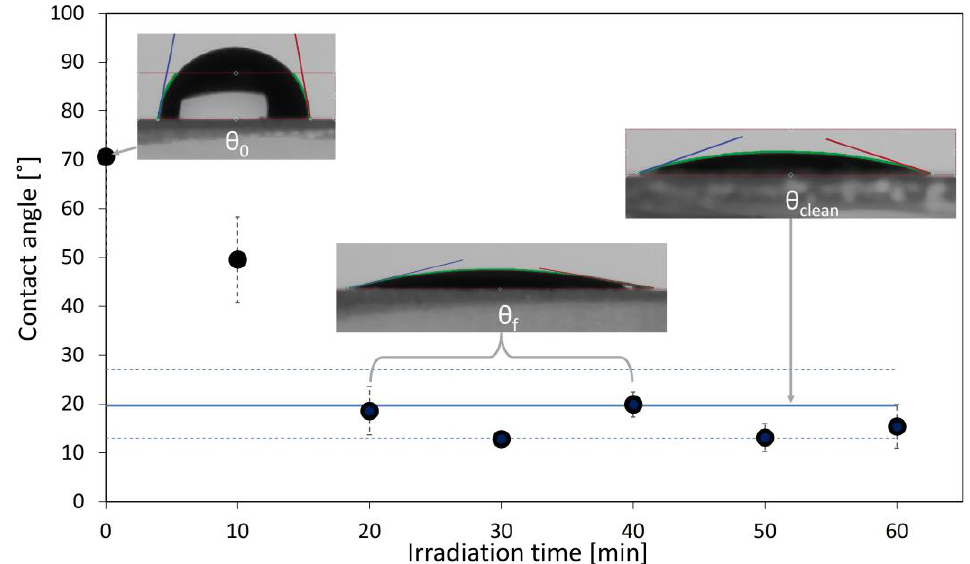
Figure 3. Example of the typical evolution of the water contact angle for a smooth, hydrophilic, photocatalytic self-cleaning surface, in this case, it is DuEL TiO 2 . The blue line is the clean surface angle with blue dashed lines as error bars. The black dots show the degradation of the deposited oleic acid as the surface regains its hydrophilicity over time.